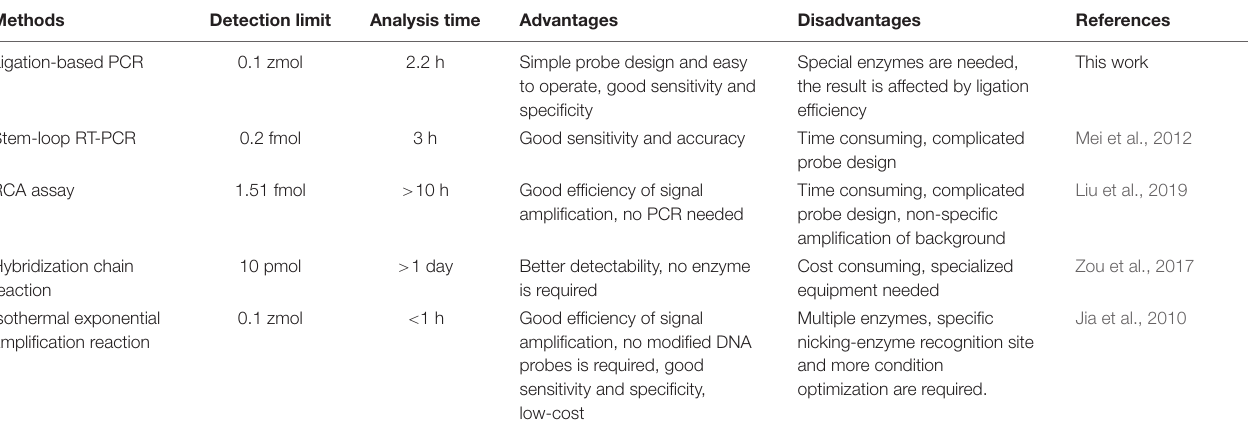
FIGURE 6 | Application of ligation-based assay for miRNA detection in genetically modified (GM) soybean. (A) Amplification plot of miR156b using deoxyribonucleic acid (DNA) as template, the total DNA was extracted from WT and GM soybean, respectively. (B) Amplification plot of miR156b using RNA as template, the total RNA was extracted from WT and GM soybean, respectively; red line: GM plants, green line: WT plants, yellow line: negative control (NTC). (C) Dynamic range and quantification of miR156b assay; red line: total RNA samples of GM plants, blue line: total RNA samples of WT plants, yellow line: negative control. (D) Correlation of total RNA input to C T values for miR156b detection. The total RNA input ranged from 10 to 0.4 µ g per ligation reaction. TABLE 2 | The comparison among ligation-based polymerase chain reaction (PCR) and the other similar methods for miRNA